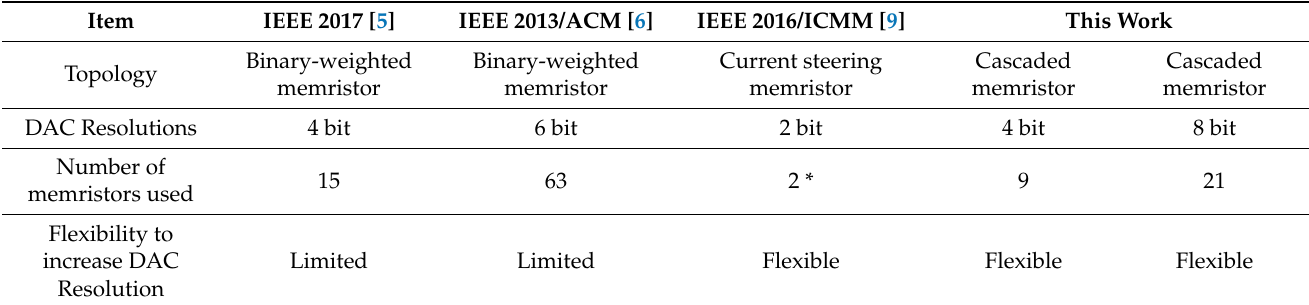
Table 5. Comparison between the proposed binary-weighted memristor DAC and the results of recent